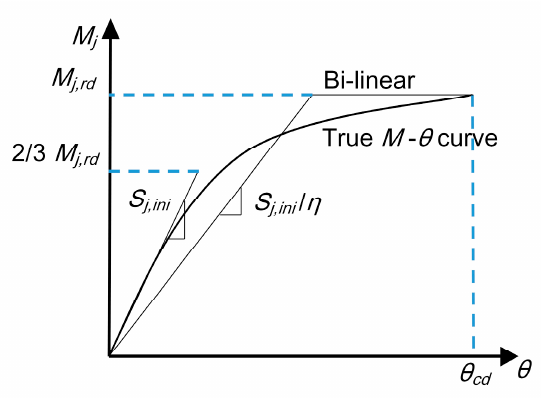
Figure 7. Moment-rotation curve of the semi-rigid joint.